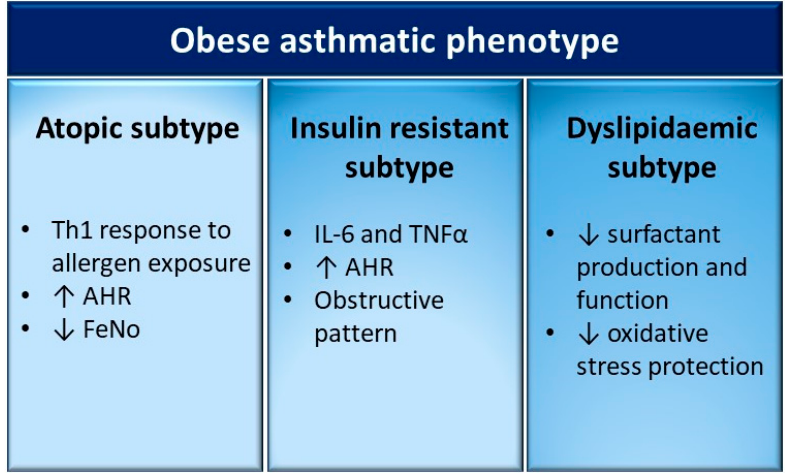
Figure 3. Potential clinical subtypes of the obese-asthmatic phenotype in children. The most relevant features of the three subtypes proposed are summarized in the relative columns. AHR: airway hyperreactivity; FeNO: fractional exhaled nitric oxide; IL-6: interleukin 6; TNF α : tumor necrosis factor α .